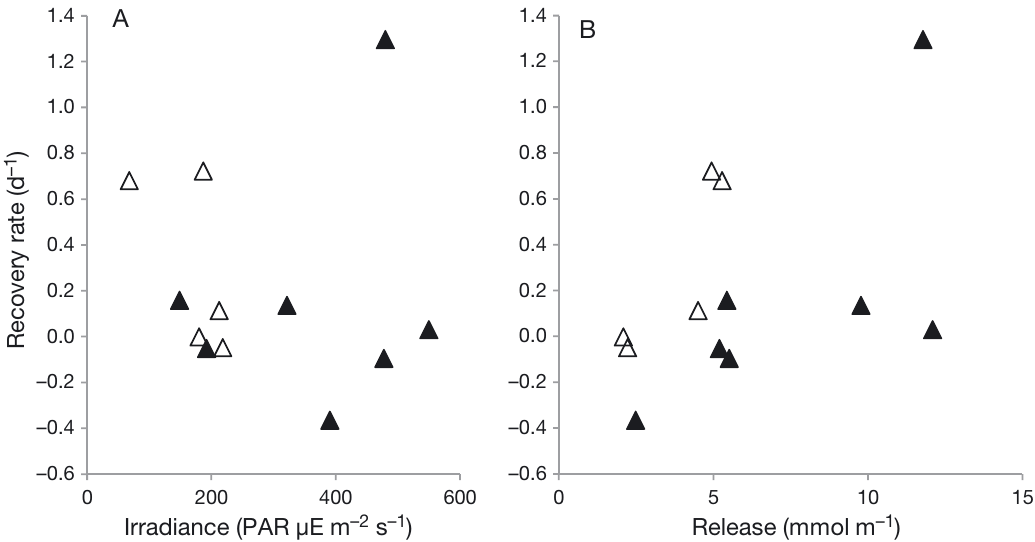
Fig. 4. (A) Relation between the recovery rate (Eq. 4) and the average light received by algal cells during the recovery period (irradiance). (B) Weight-dependent release of nutrients during the incubation, estimated using the relation described by Van Broekhoven et al. (2014) and correlated to the recovery rate. Black symbols indicate the blocks in 2010; white symbols show blocks in 2011. For these figures, the change in nanophytoplankton concentration was